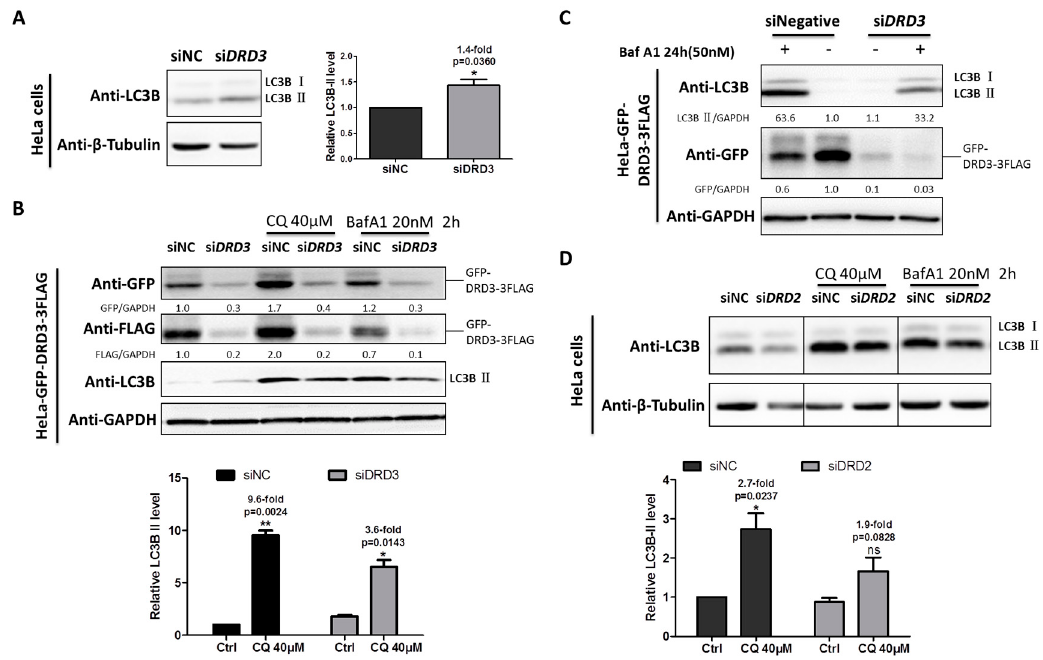
Figure 1. DRD3 and DRD2 knockdown inhibit autophagic flux. ( A ) Dopamine receptor D3 (DRD3) RNAi in HeLa cells was used to test the relative level of LC3B-II. ( B ) DRD3 RNAi was combined with autophagy inhibitors Chloroquine (CQ) (40 μ M) or Baf A1 (20 nM) for 2 h to detect the autophagic flux in HeLa cells stably expressing GFP-DRD3-3FLAG. ( C ) DRD3 RNAi was combined with high concentration of Baf A1 (50 nM) for 24 h to examine the autophagic flux in HeLa cells stably expressing GFP-DRD3-3FLAG. ( D ) DRD2 RNAi in HeLa cells was combined with autophagy inhibitors CQ (40 μ M) or Baf A1 (20 nM) for 2 h to detect the autophagic flux. Experiments were repeated at least three times and representative Western blots are shown. Densitometric analysis was performed and quantification results were labeled below the corresponding blots. * p < 0.05, ** p < 0.01.